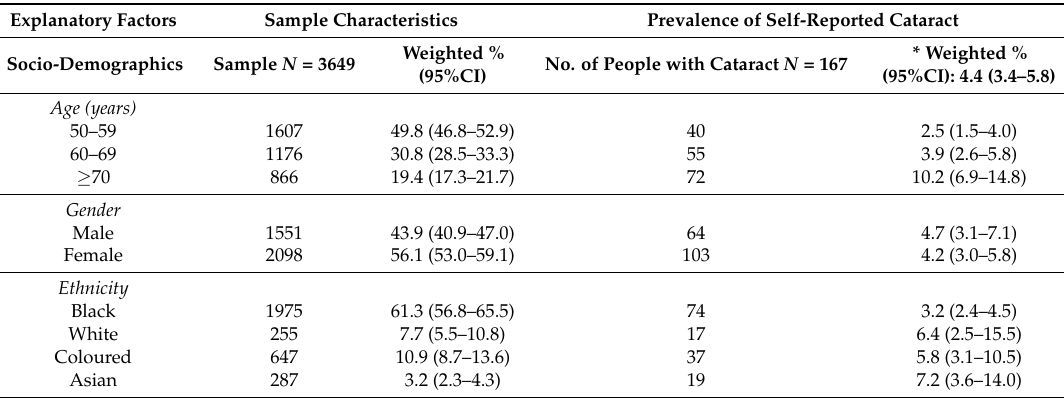
Table 1. Sample characteristics and prevalence of self-reported